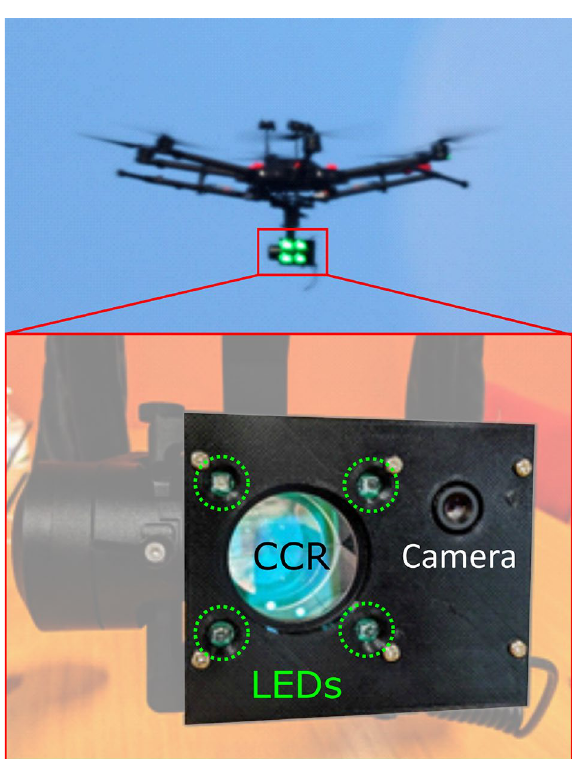
Figure 5. Top: the drone in operation, with MV beacon LEDs visible on the gimbal-mounted optical payload. Bottom: close-up of the optical payload showing the beacon LEDs, CCR, and